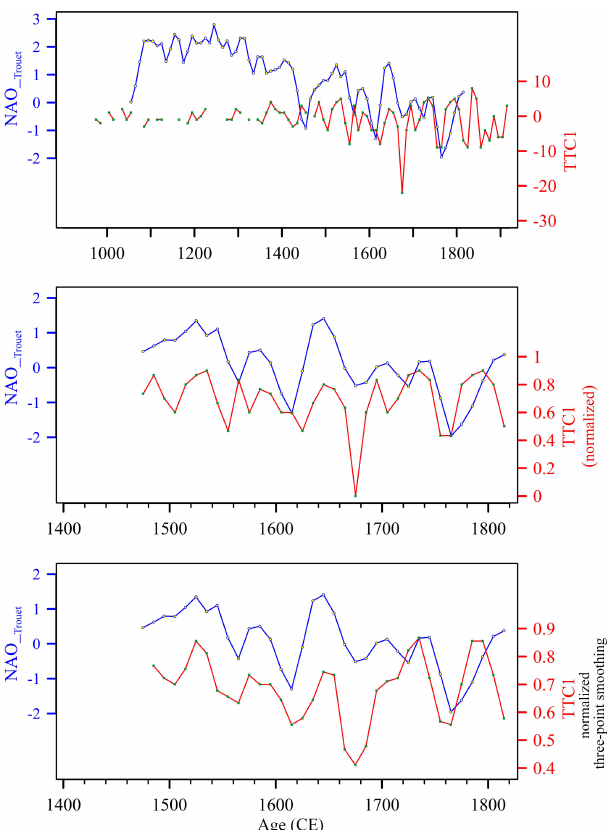
Figure 8. The relation between the NAO Trouet (Trouet et al., 2009) and the